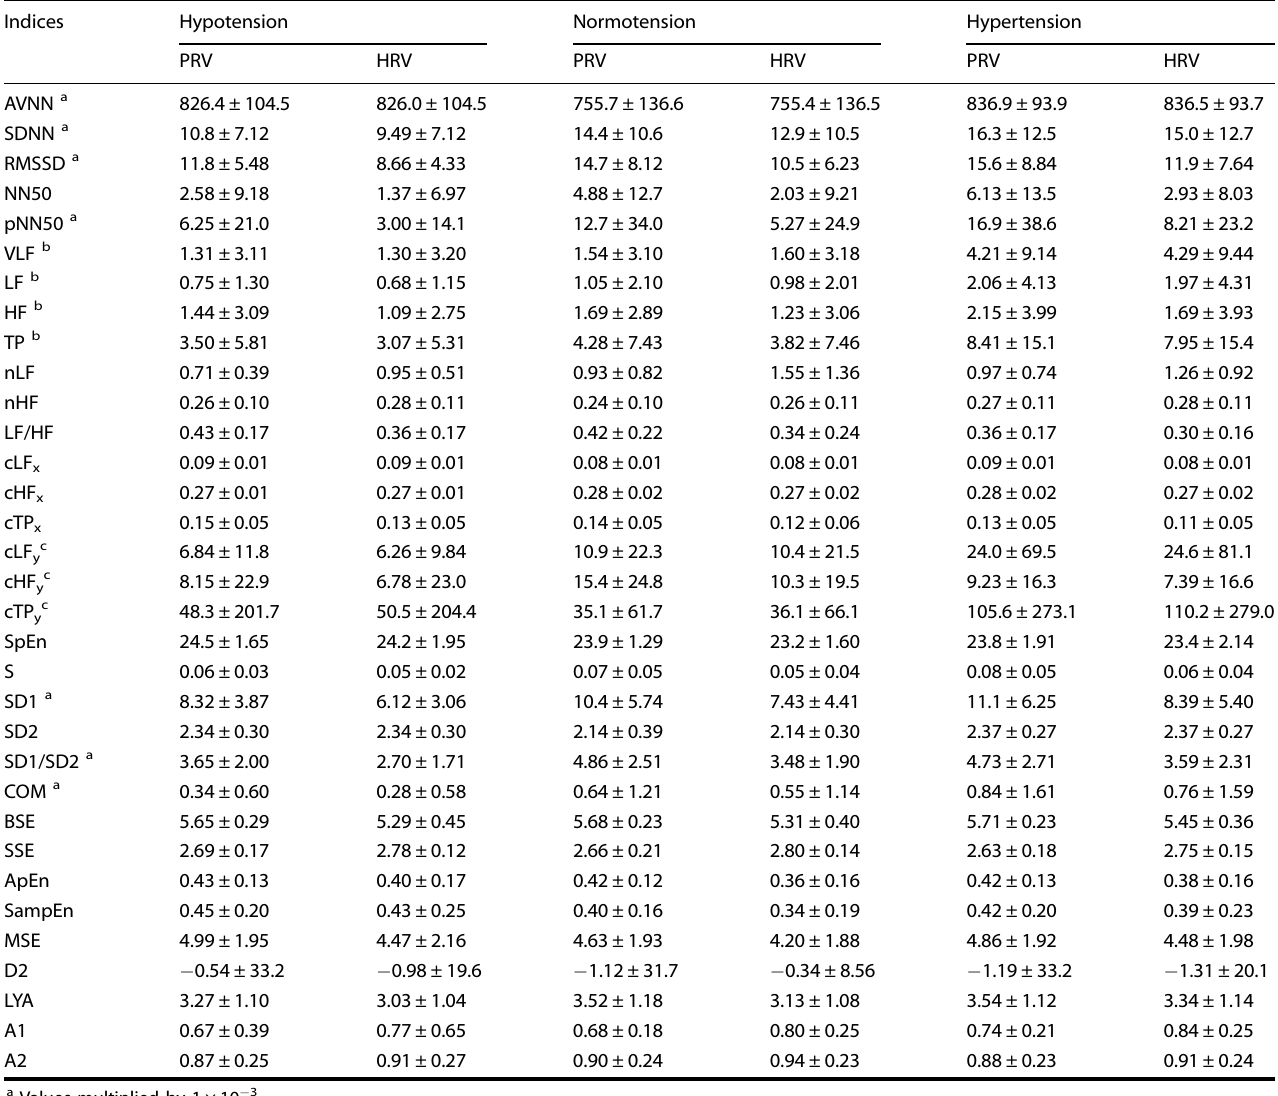
Table 2. Mean ± standard deviation of indices measured from pulse rate variability (PRV) and heart rate variability (HRV) under each blood pressure